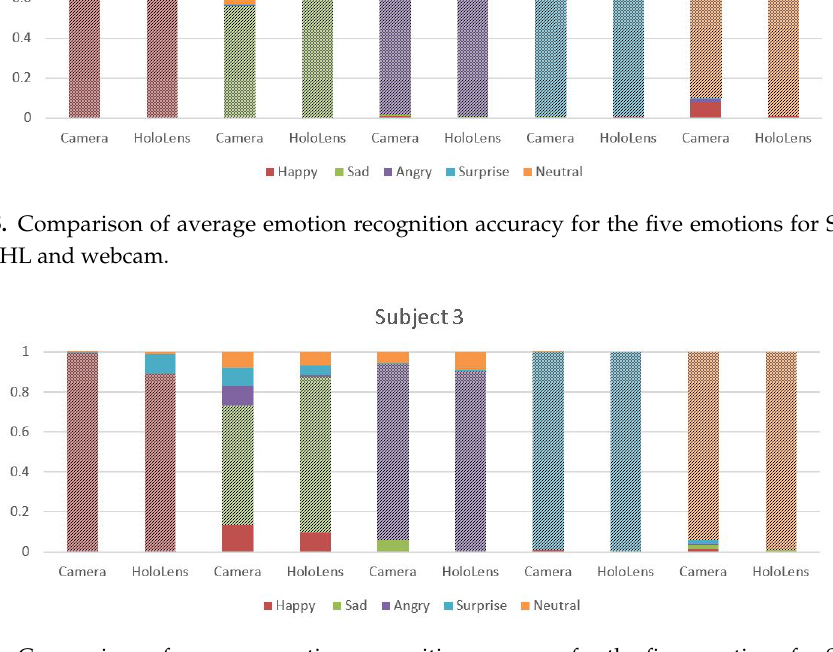
Figure 6. Comparison of average emotion recognition accuracy for the five emotions for Subject 3 using MHL and webcam.